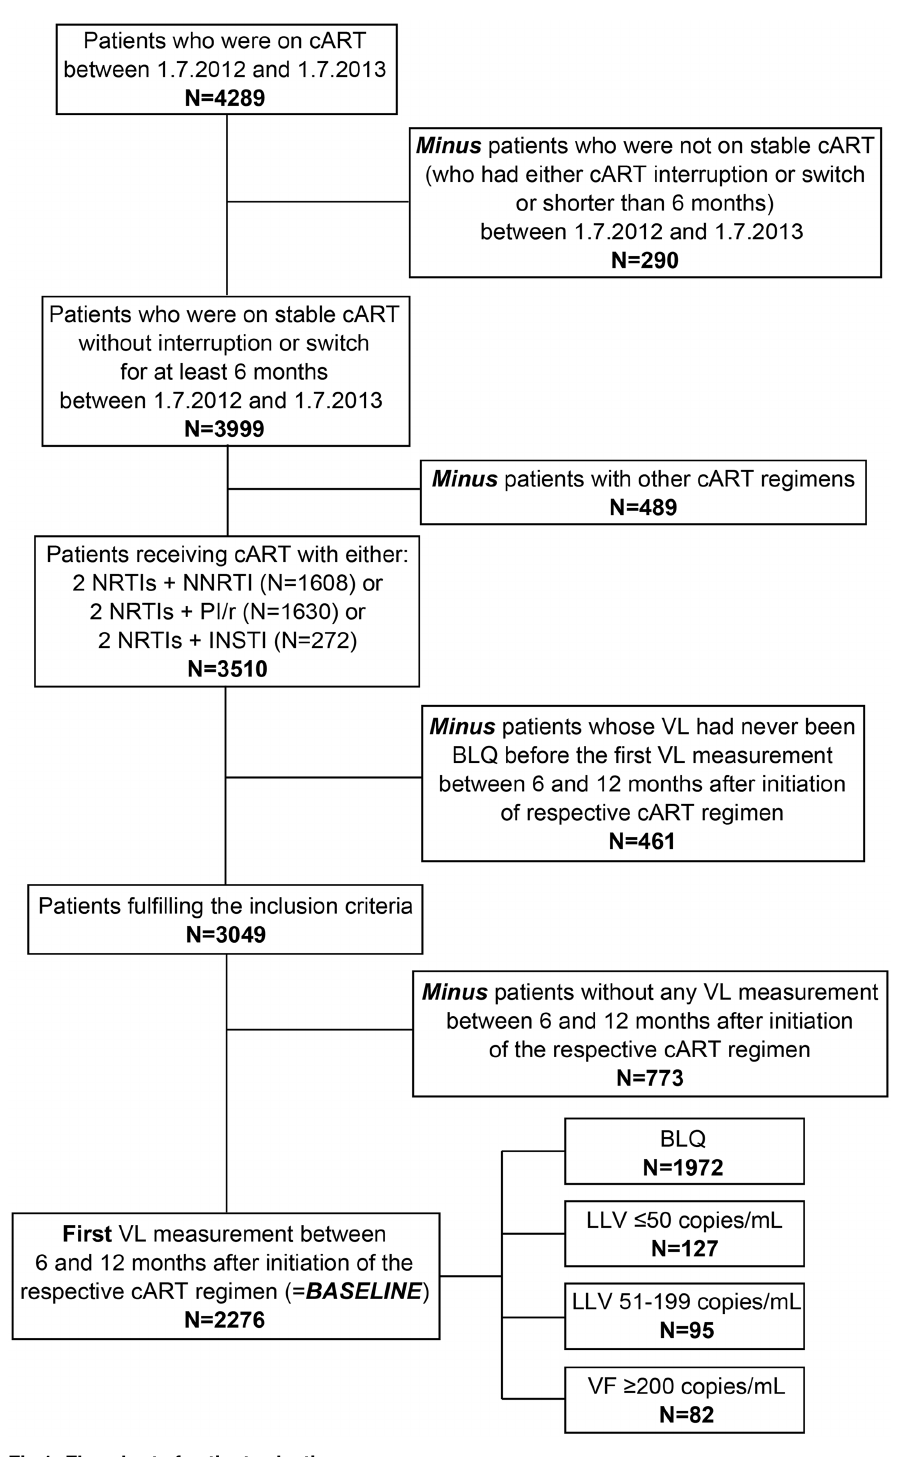
PLOS ONE | DOI:10.1371/journal.pone.0142923 November 13,